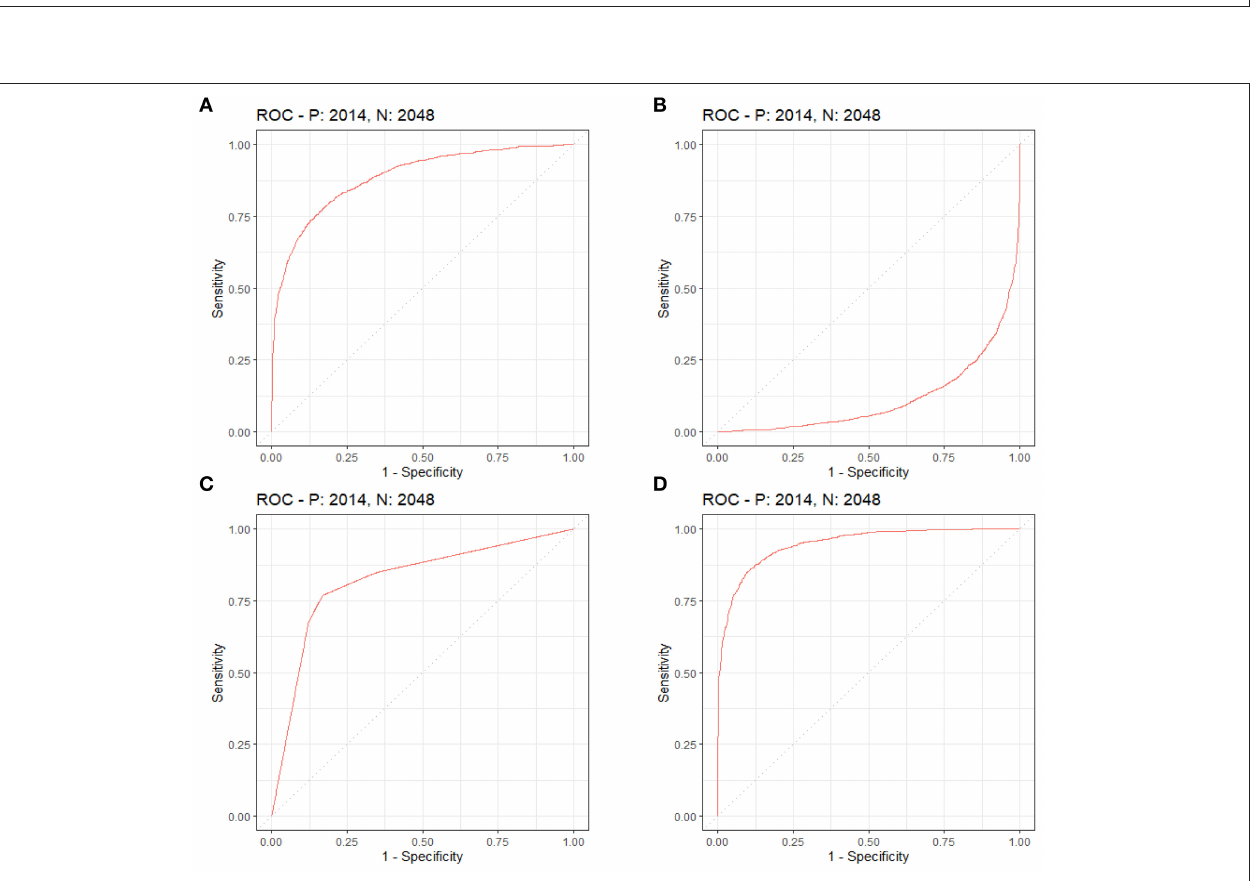
FIGURE 2 | Each machine learning model was assessed by the ROC curve, which plots a curve according to its true positive rate ( y -axis) against its false positive rate ( x -axis). The larger area under the curve, the better the prediction accuracy of the model. (A) Logistic regression. (B) Support vector machine (SVM). (C) Decision tree classification. (D) Random forest